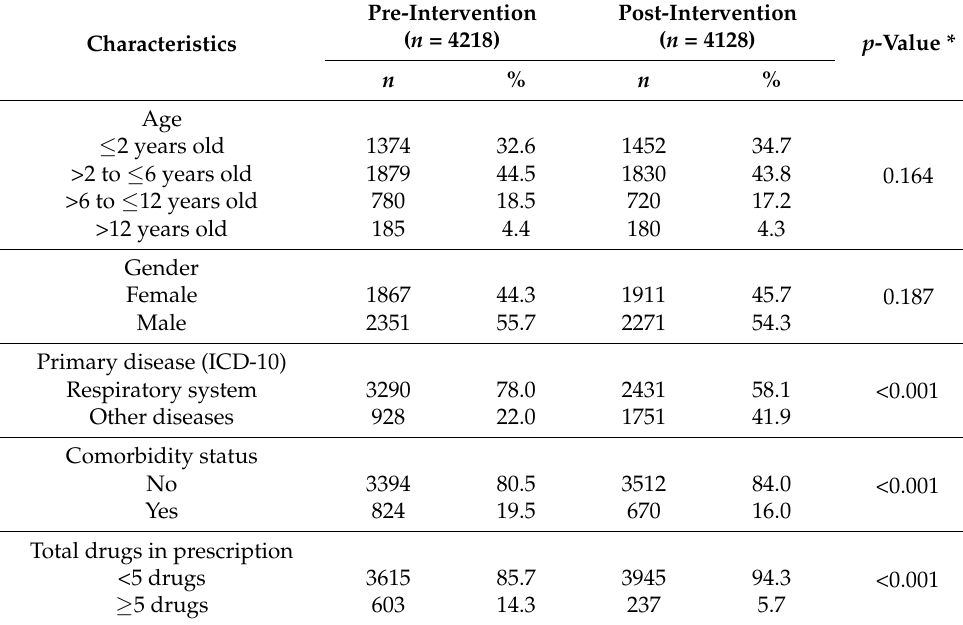
Table 2. Patient characteristics in pre- and post-intervention